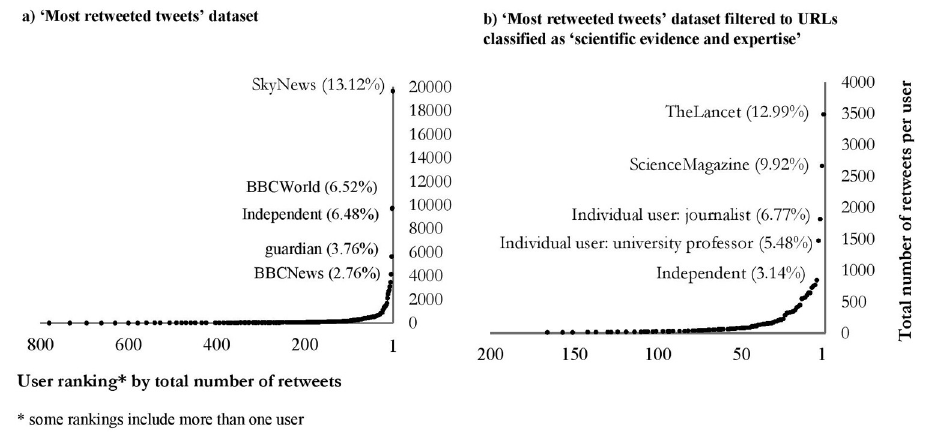
Fig 6. User profile ranking by number of retweets (x axis) and total number of retweets (y-axis). a) ‘Most retweeted tweets’ dataset b) ‘Most retweeted tweets’ dataset filtered to URLs classified as ‘scientific evidence and expertise’.